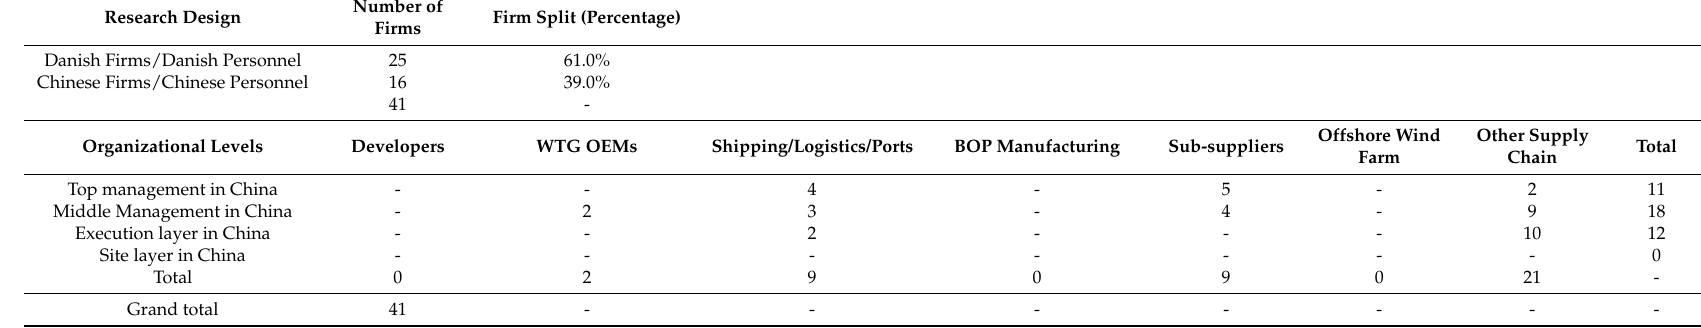
Table 5. Secondary empirical data collection efforts in